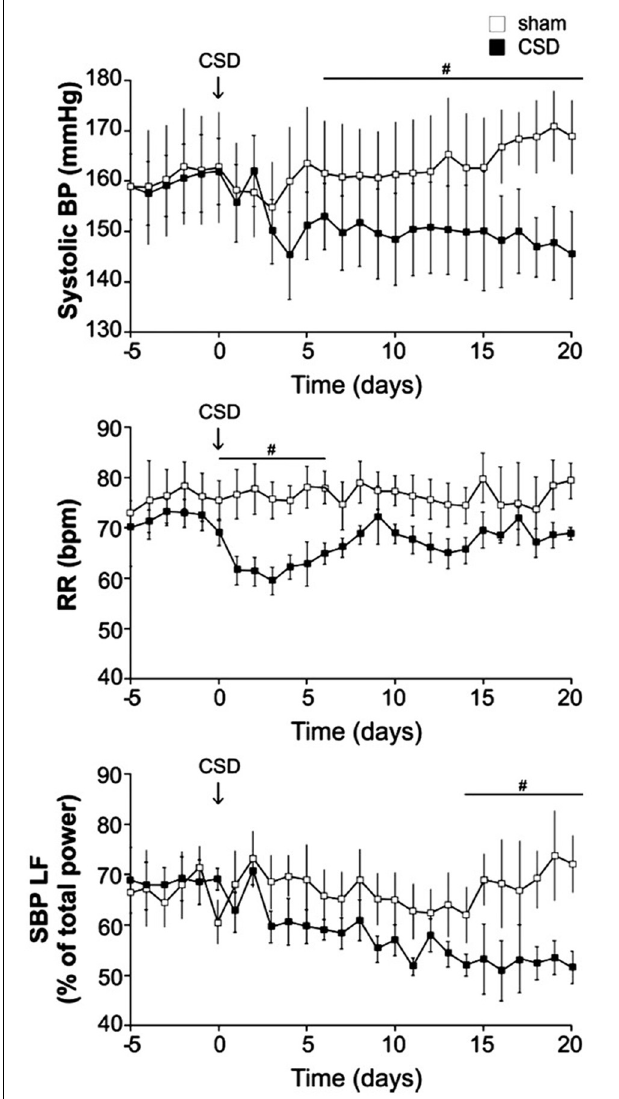
FIGURE 13 | In SHR, carotid body denervation decreases blood pressure, respiratory frequency and sympathetic nerve activity. Bilateral denervation of carotid sinus nerves (CSD) significantly decrease resting blood pressure, respiratory frequency (RR; transiently) and a SNA index (SBP LF) in SHRs. Systolic pressure decreased over 5–10 days to reach a plateau of − 17 ± 3mmHg ( n = 10, P < 0 . 05). Mean arterial and diastolic pressures fell by − 15 ± 2 ( P < 0 . 05) and − 17 ± 2 ( P < 0 . 05)mmHg, respectively. Lowered arterial pressure was maintained with no sign of recovery for at least 3 weeks. SBP LF: Systolic blood pressure, low frequency band. (Figure used with permission from Abdala et al., 2012). # Significant difference ( P < 0 . 05 )